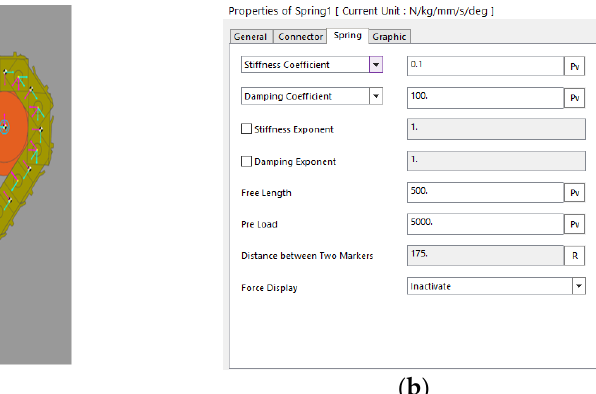
5 of 33 Figure 2. 3D models of loading box used for bee frame transportation ( a ) and beehive transportation ( b ). (1) Base panel and front panel, (2) front middle lower panel, (3) front middle upper panel, (4) right side lower panel, (5) right side upper panel, (6) middle lower panel, (7) middle upper panel, (8) lower cross baffle, (9) upper cross baffle, (10) rear middle lower panel, (11) rear middle upper panel, (12) rear baffle, (13) right side upper panel, (14) right side lower panel, (15) bolt fastening device, (16) auxiliary plate 1 of rear baffle, and (17) auxiliary plate 2 of rear baffle.